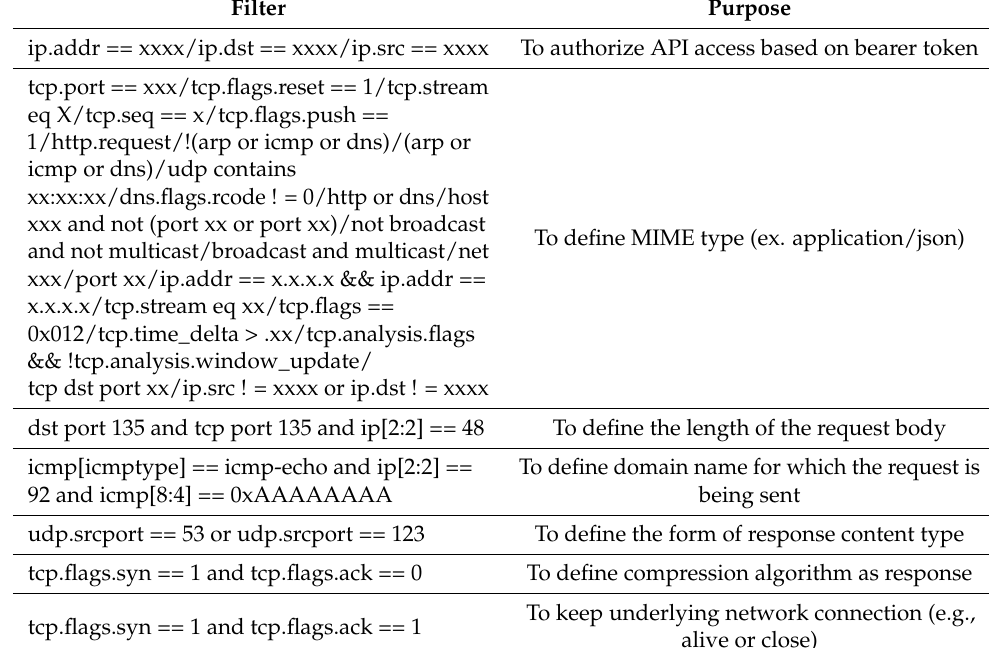
Table 7. Explicit filter pattern to analyze network traffic.